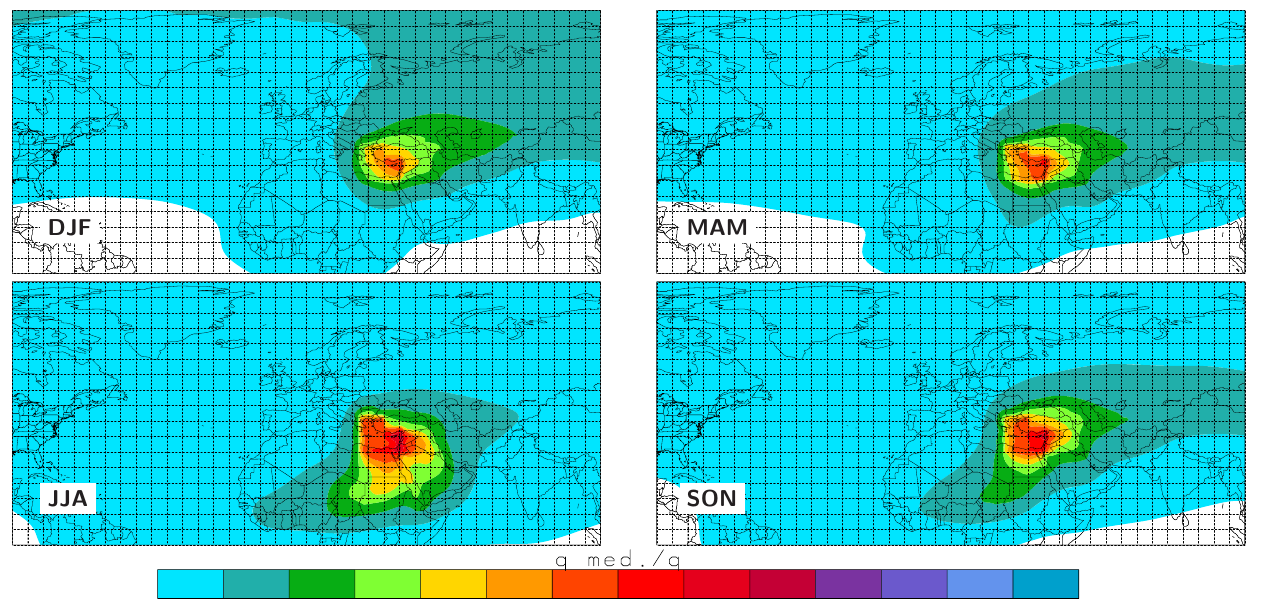
Fig. 9. Same as Fig. 7 (moisture ratio) but for the eastern Mediterranean basin.